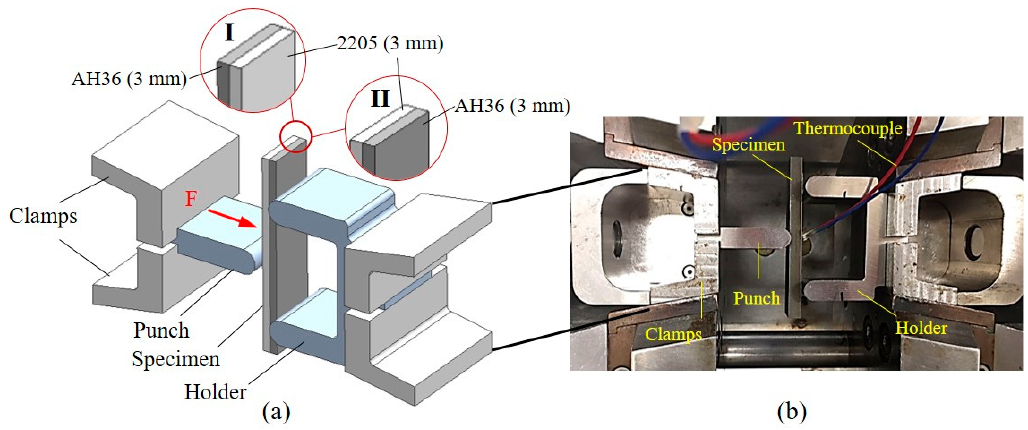
Figure 3. ( a ) Schematic diagram of hot bending setup, and ( b ) the test simulator assembled with a bending specimen.